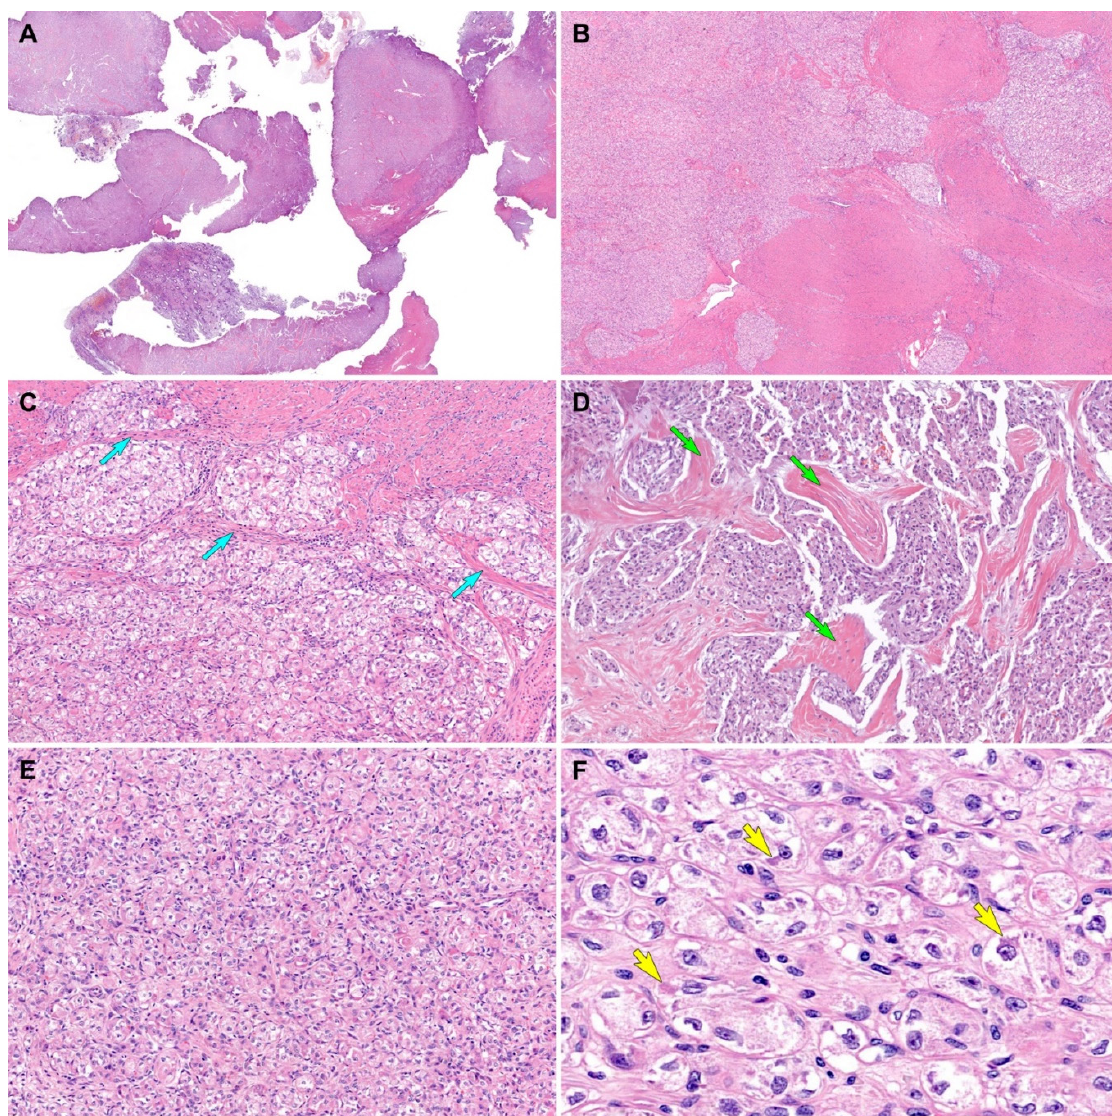
Figure 2. Histological findings (case 1). ( A ) Scanning-power magnification reveals that the myomec- tomy specimen consists predominantly of tumor tissue infiltrating the myometrium. ( B ) Low-power magnification reveals that the tumor irregularly permeates the myometrium and forms variable-sized islands of tumor cells. ( C ) Thin fibrovascular septa (blue arrows) surround the tumor cell nests. ( D ) The tumor cells were organized in irregular-shaped sheets embedded in a background of dense hyalinized stroma (green arrows). ( E ) A solid, diffuse growth pattern with little or no intervening stroma is also noted. ( F ) The high-power view demonstrates large polygonal cells possessing clear or vacuolated cytoplasm and distinct cell borders. In some microscopic foci, eosinophilic intracyto- plasmic materials (yellow arrows) are located closely adjacent to the nuclei. Original magnification: ( A ) 10 × ; ( B ) 20 × ; ( C , D ) 40 × ; ( E ) 100 × ; ( F ) 400 ×